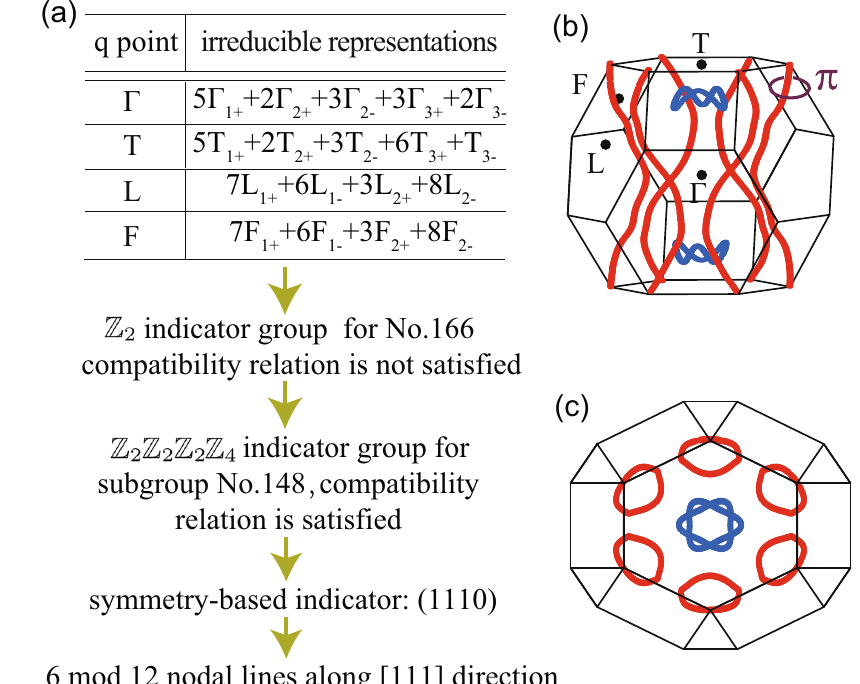
Fig. 2 Topological diagnosis for the nodal lines in Ni 3 In 2 S 2 . a Diagnostic process for topological nodal lines in Ni 3 In 2 S 2 by symmetry-based indicator theory and beyond (see text for more details). b Distributions of six endless node-line (red) and two node-ring (blue) band crossings in the fi rst BZ, carrying π Berry phase. c Top view of the nodal lines and nodal rings in the